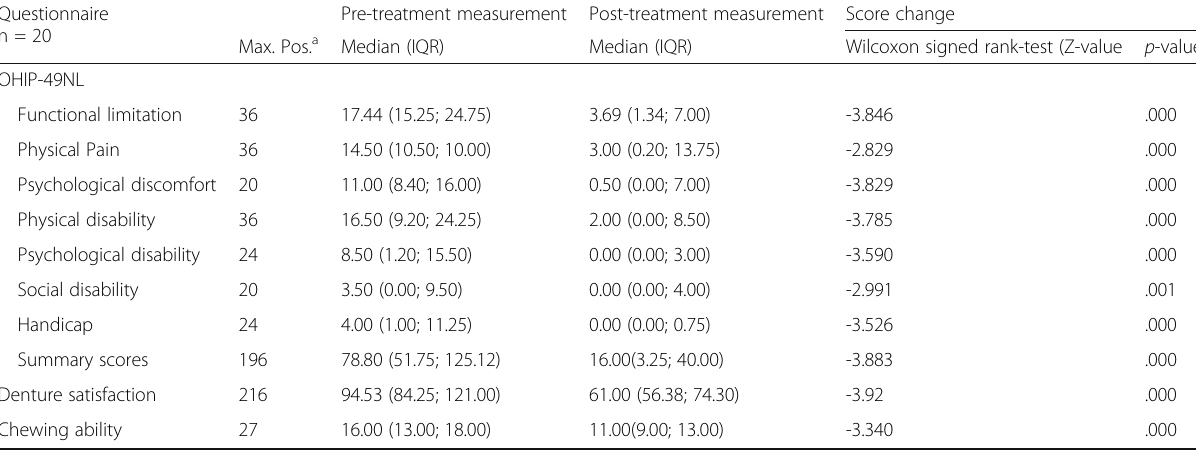
Table 2 OHIP-49NL. Denture satisfaction and chewing ability scores: pre- and post-treatment results for all participants Questionnaire Pre-treatment measurement Post-treatment measurement Score n = 20